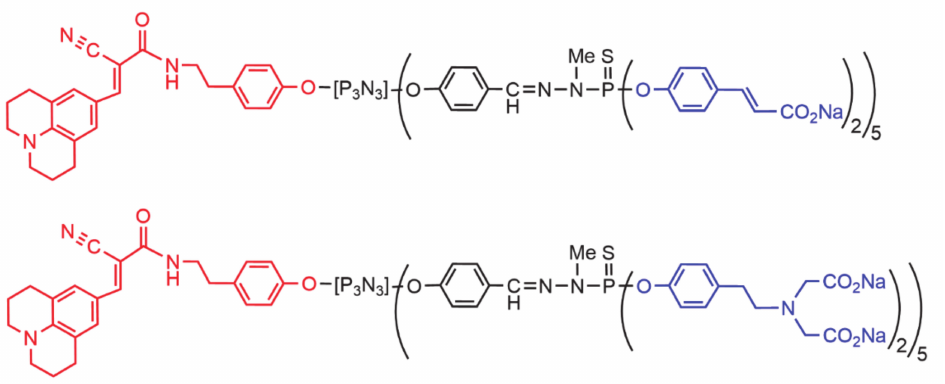
Figure 9. Examples of dendrons functionalized by one julolidine derivative at the core and 10 carboxylate or azabiscarboxylate terminal